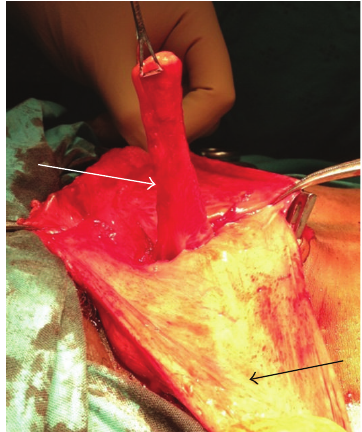
Figure 1: Lateral view of appendix (white arrow) within right inguinal hernia sac (indicated by black arrow).